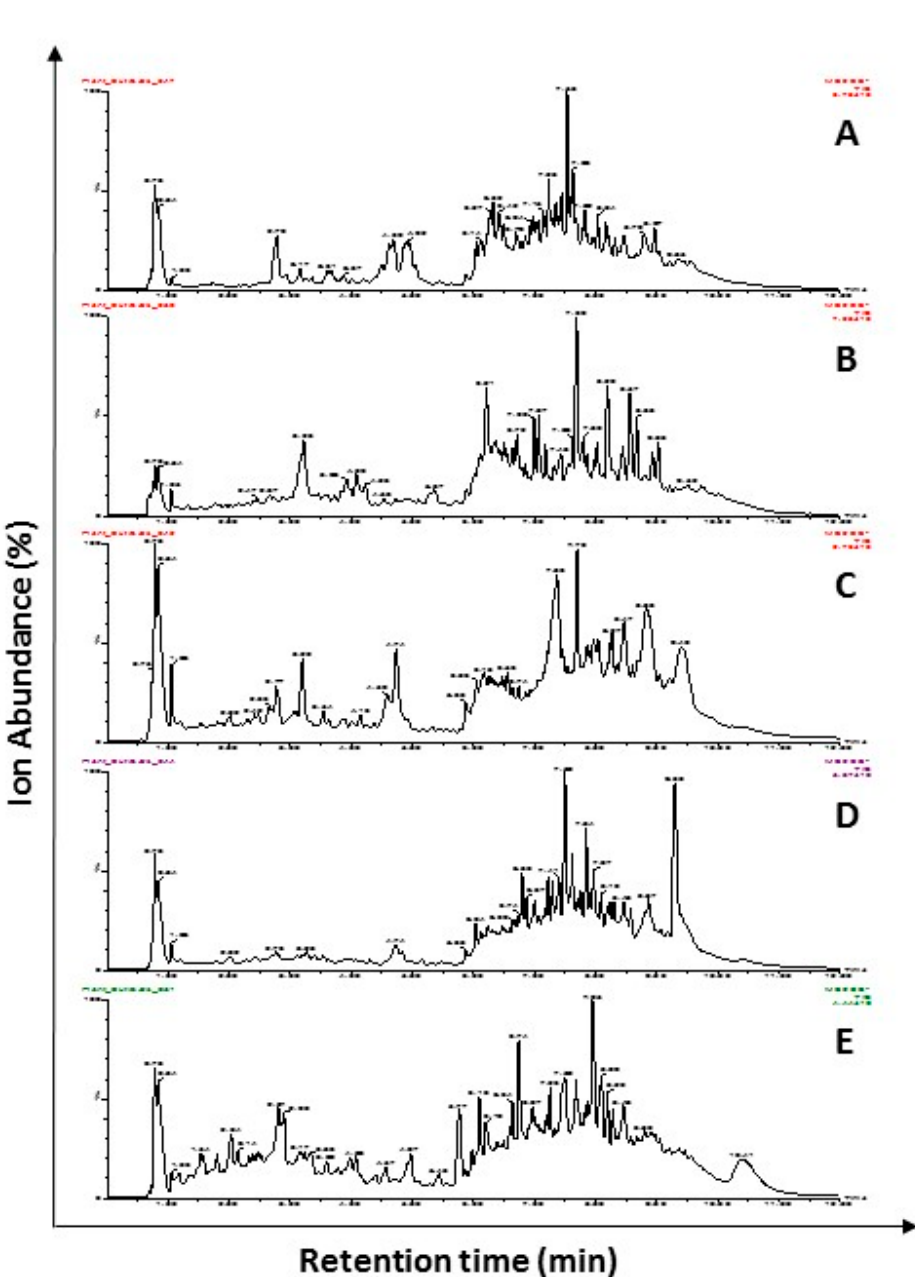
Figure 1. Total ion chromatograms (TIC) of deprotonated selected ion monitoring modes spectra of UPLC-ESI-MS/MS analysis of ethanol extracts of licorice roots ( A ), sage leaves ( B ), purple coneflower flowers ( C ), purple coneflower stems ( D ), and slippery elm inner barks ( E ). Full scan followed by SIM mode of UPLC-ESI-MS/MS was performed for the identification of phytochemicals present in the extracts. Relative ion absorbance vs. retention times is shown in